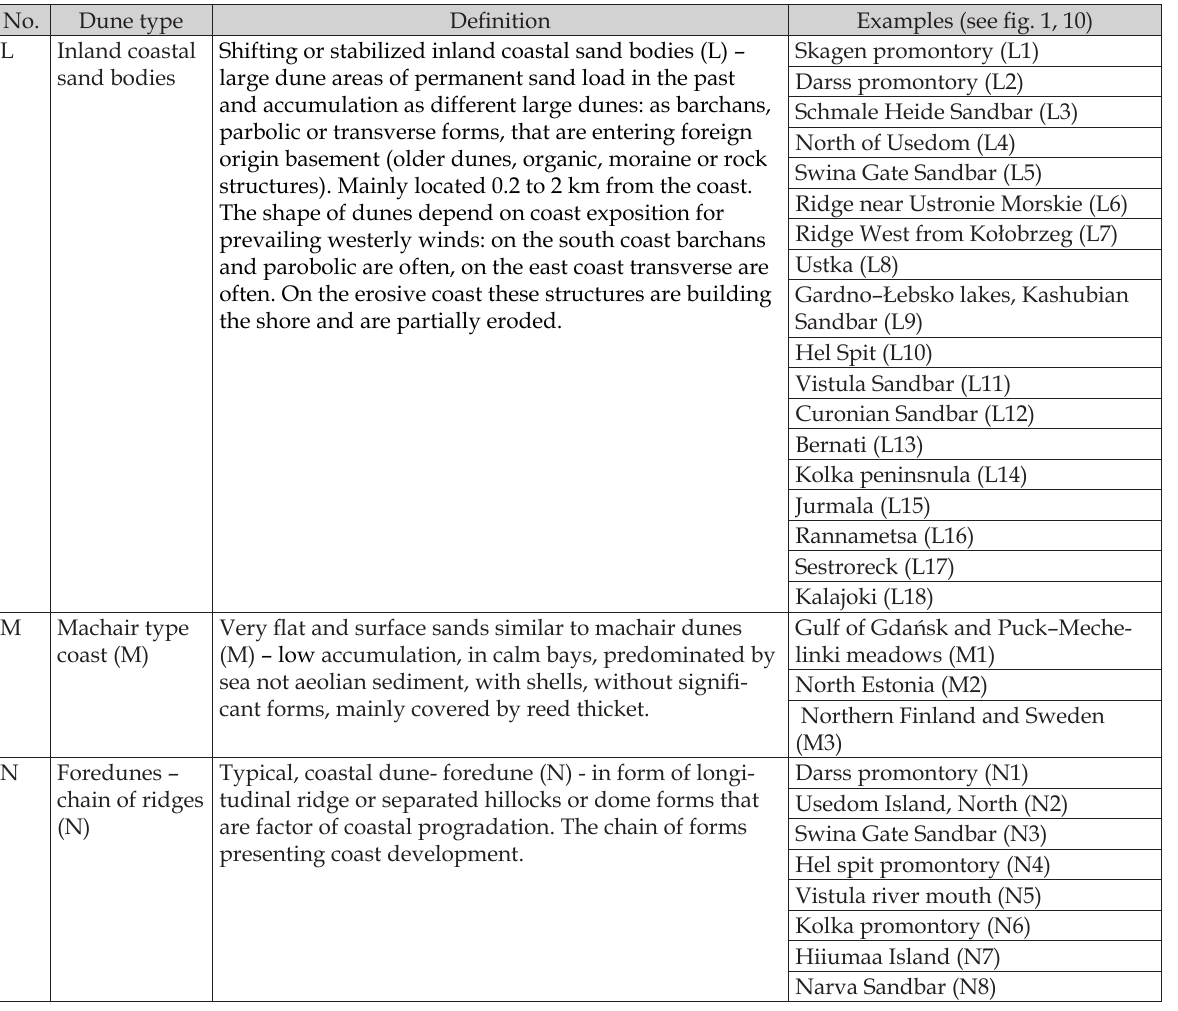
Table 2. List of main sandy forms at sandbars along the Baltic Sea coast (Łabuz 2017, unpublished). No. Dune